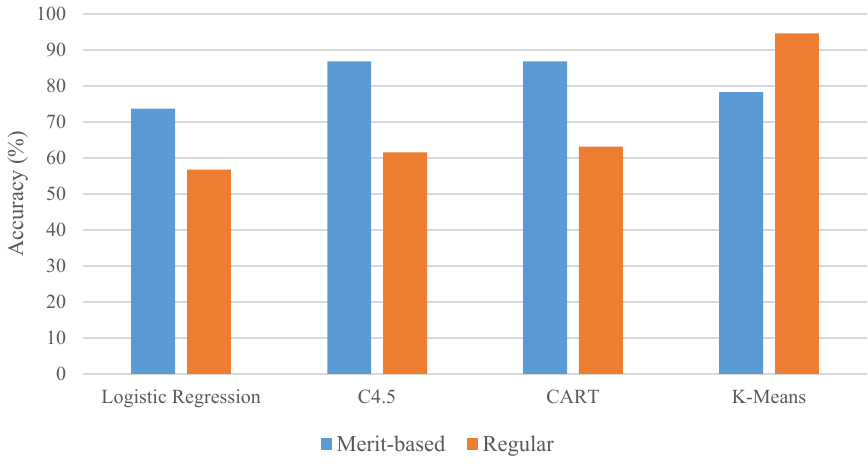
Fig. 1. Comparison of Accuracy from Previous